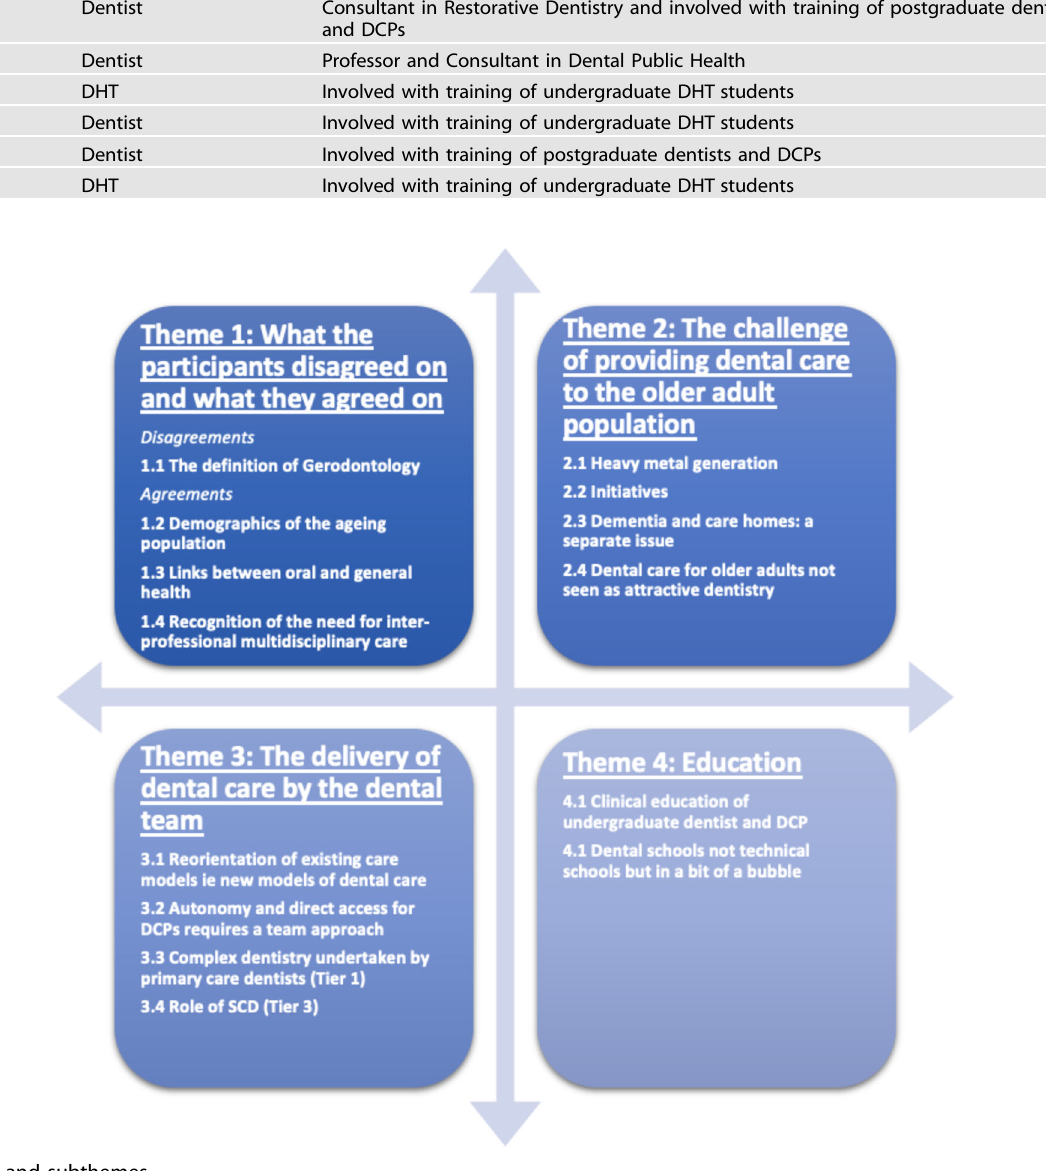
Fig. 1 Themes and